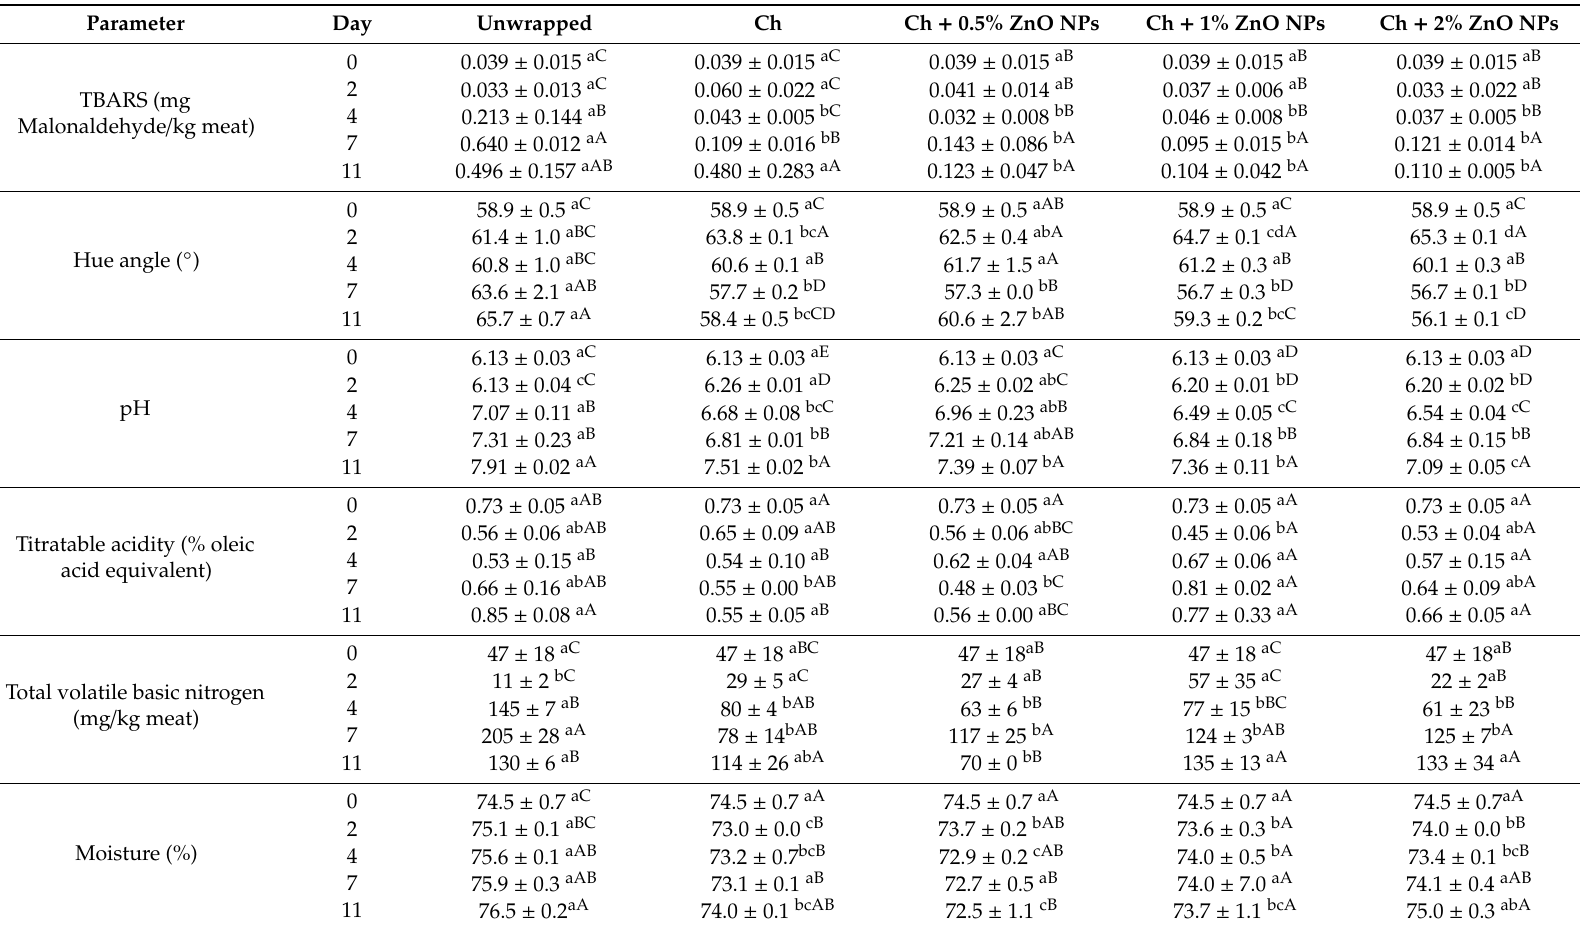
(A-E) : Within each parameter, values in the same column not sharing upper case superscript letters indicate statistically significant di ff erences among days ( p < 0.05 ). (a–c) : Within each parameter, values in the same line not sharing lower case superscript letters indicate statistically significant di ff erences among formulations ( p < 0.05 ). Thiobarbituric acid